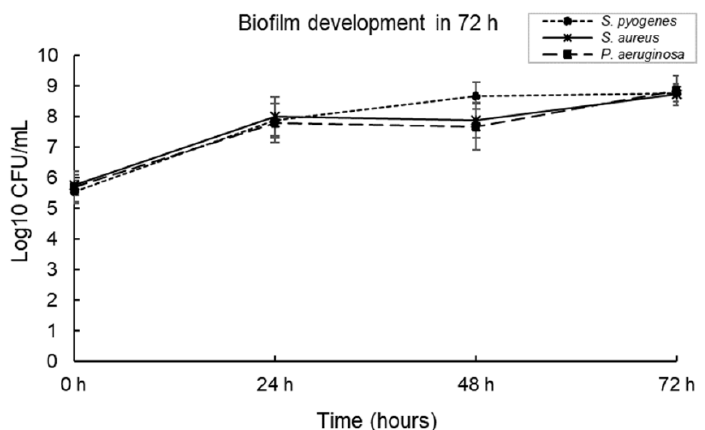
Figure 5. A three-species biofilm grown in the Duckworth Biofilm Device (DBD) for 72 h at 33 °C.